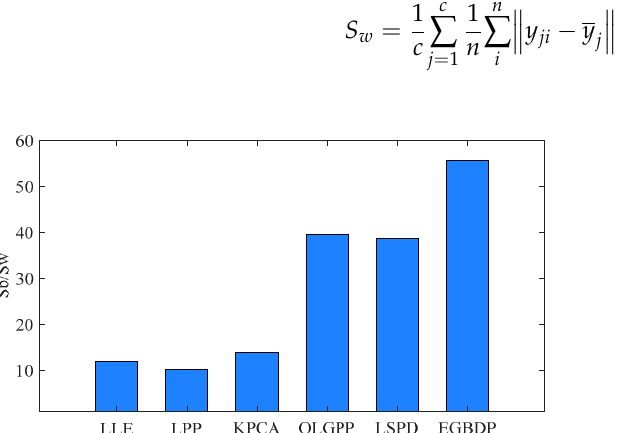
Figure 7. Low-dimensional feature separability index based on different algorithms.